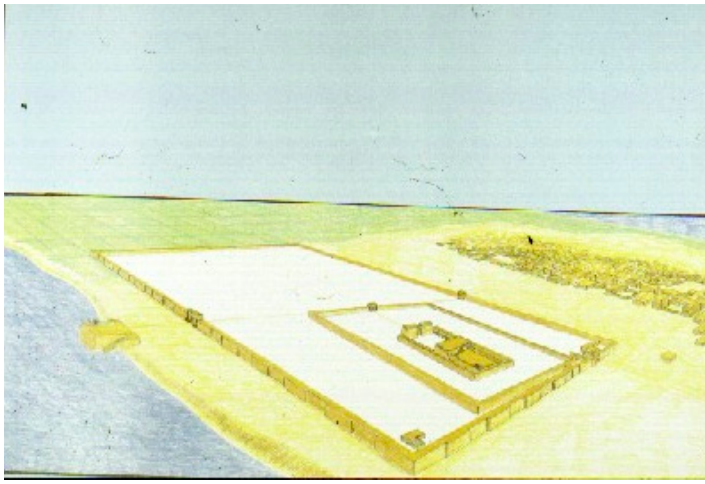
Figure 26. 3D reconstruction of the ancient site of Tell Tebilla. Imagery courtesy Greg Mumford.